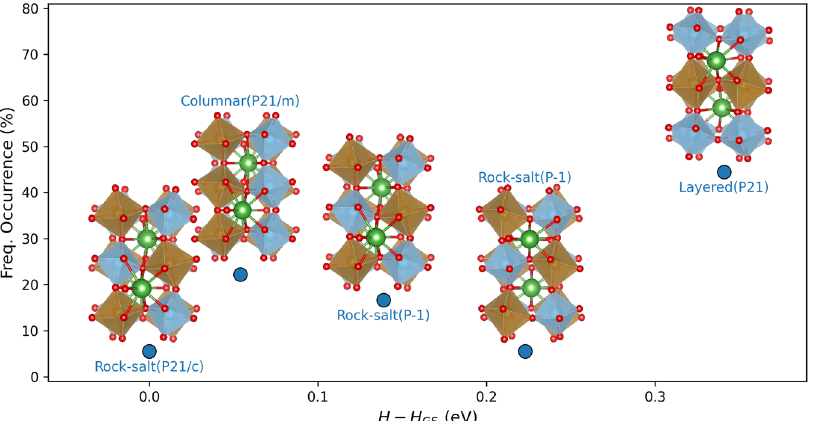
Fig. 3 Frequency of occurrence of La 2 TiFeO 6 perovskite structures captured by AIRSS within 400 meV of the ground state. The rock-salt with symmetry P 21 /C was found to occur less often than the columnar and layered phases. Above 100 meV other rock-salt phases with reduced symmetry and different octahedral rotations were found. The competition of these phases and the higher entropy associated with the more frequently occurring phases align with the experimentally observed disorder. In the reported structures, the atoms are labeled with different colors: green for La, red for O, blue for Ti, and brown for